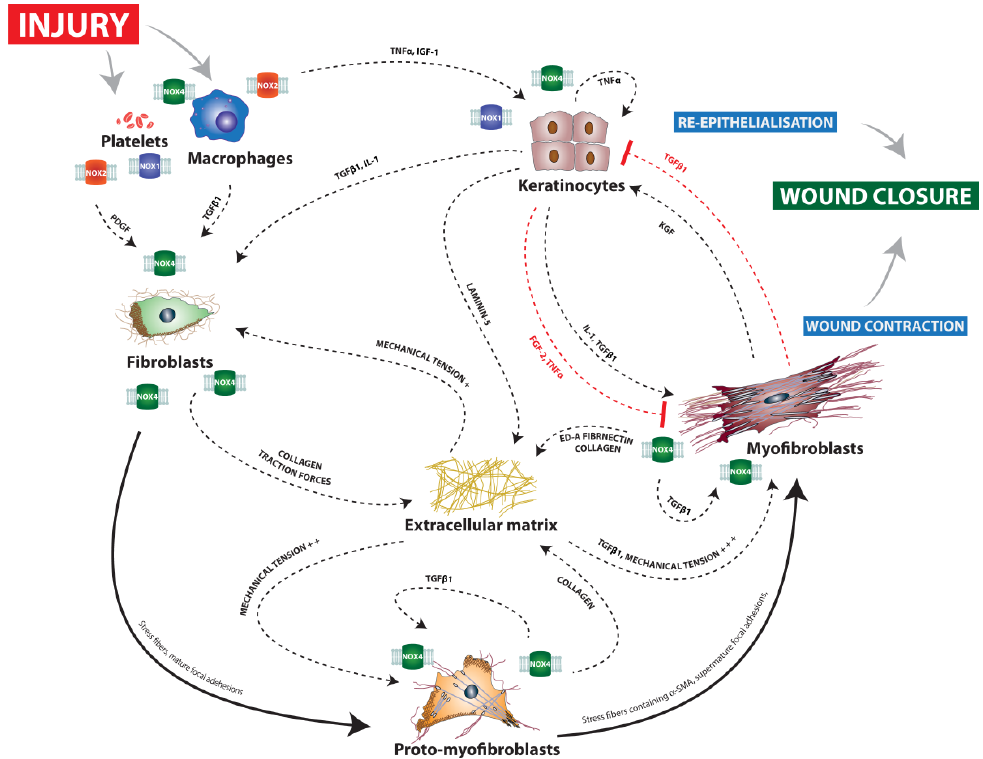
Figure 1. Schematic view of the interactions underlying wound closure and major implications of NOX enzymes. Solid arrows represent differentiation processes, dashed arrows promoting interactions and red dashed T arrows inhibitory interactions. After injury, the activation of platelets and macrophages leads to the production of large amounts of ROS. NOX2 and NOX1 play a major role in these processes. NOX4 has also been suggested to play a role in macrophage recruitment. Growth factors released by platelets and macrophages trigger the proliferation and migration of keratinocytes, leading to re-epithelialization. NOX1 and NOX4 possibly play a direct role in keratinocyte migration. Different precursor cells and fibroblasts are attracted to the wound site by growth factors including TGF β 1 and PDGF, a process that is likely to be mediated by NOX4. Migrating fibroblasts stiffen the extracellular matrix (ECM) by producing collagen and inducing traction forces due to their migratory activity. Also, NOX4 seems to play a crucial role here. The stiffened ECM induces the differentiation of fibroblasts into moderately contractile proto-myofibroblasts. Proto-myofibroblasts produce large amounts of ECM components, including mostly collagen, further stiffening the ECM, a process that has been shown to be dependent on NOX4. In addition, they release TGF β 1 from dormant ECM deposits via integrin expression. Induced by the further increased mechanical tension of the ECM, highly contractile myofibroblasts develop, characterized by de novo expression of α SMA, which enables them to generate greater contractile forces. The role of NOX4 in cutaneous myofibroblast differentiation is controversial as it has been shown that NOX4 is a prerequisite for myofibroblast differentiation during pulmonary fibrosis but does not seem to be required during cutaneous wound